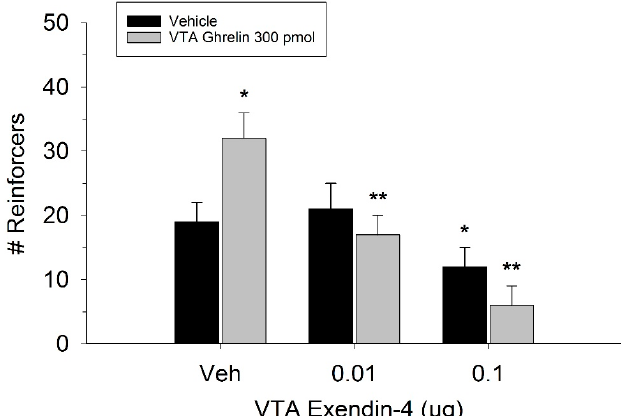
Figure 3. Effect of VTA Ex-4 pretreatment on ghrelin-induced operant responding for food. While only the higher dose of Ex-4 reduced responding when injected into the VTA alone, both doses of the GLP-1 agonist reliably attenuated ghrelin’s stimulatory action on food reinforcement. Values represent mean number of reinforcers ± SEM; n = 8. * p < 0.05 compared to vehicle (Veh). ** p < 0.05 compared to ghrelin administered with Veh pretreatment.